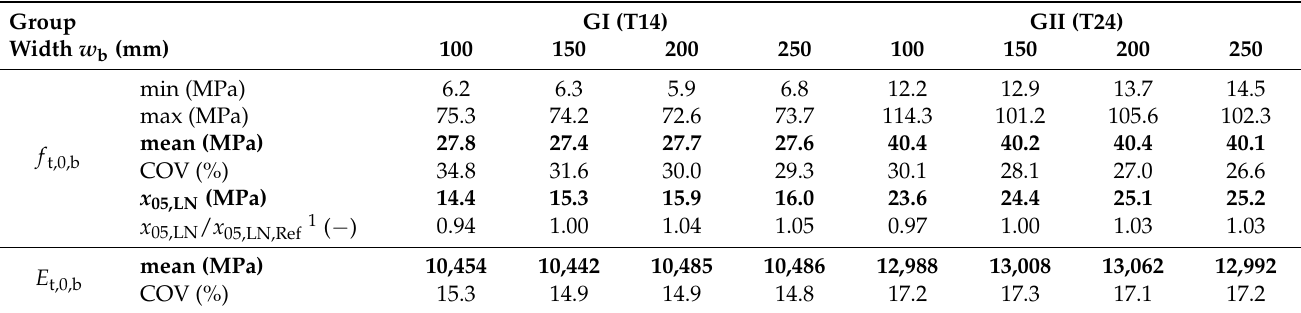
Table 7. Main statistics of the tensile strength f t,0,b and modulus of elasticity in tension E t,0,b parallel to the grain in (MPa) calculated from 1.5 × 10 4 simulated boards for each width and group, considering a test length of l b = 9 × w b and l b = 5 × w b , respectively, for f t,0,b and E t,0,b according to EN 408 [19].